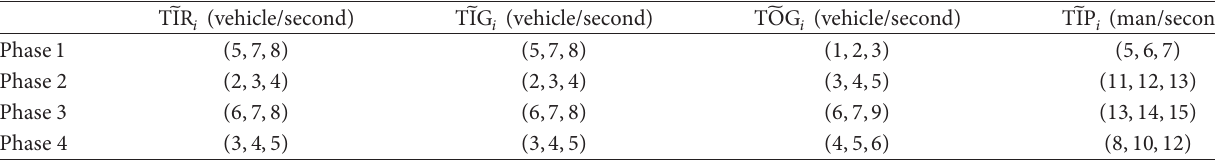
Table 1: The fuzzy entry and exit rates per phase of intersection.